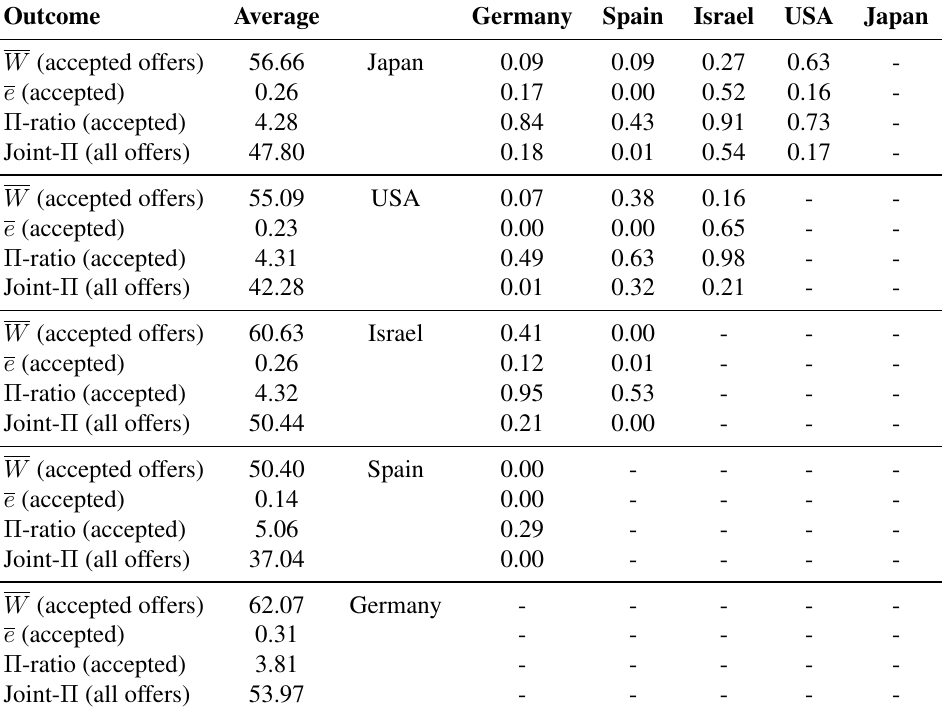
p -values of pairwise comparisons of different outcomes, using a two-sided robust rank order test, in the different fixed-matching treatments. Unit of observation: average outcome per worker (averaged over Rounds 2–9). “ Π -ratio” includes only cases where the firm’s profit is larger than 0. Finally, “Average” denotes the average value of the outcome of the comparison. For instance, the average wage offer in Japan is equal to 56.66 experimental currency units (ECU) (see Table